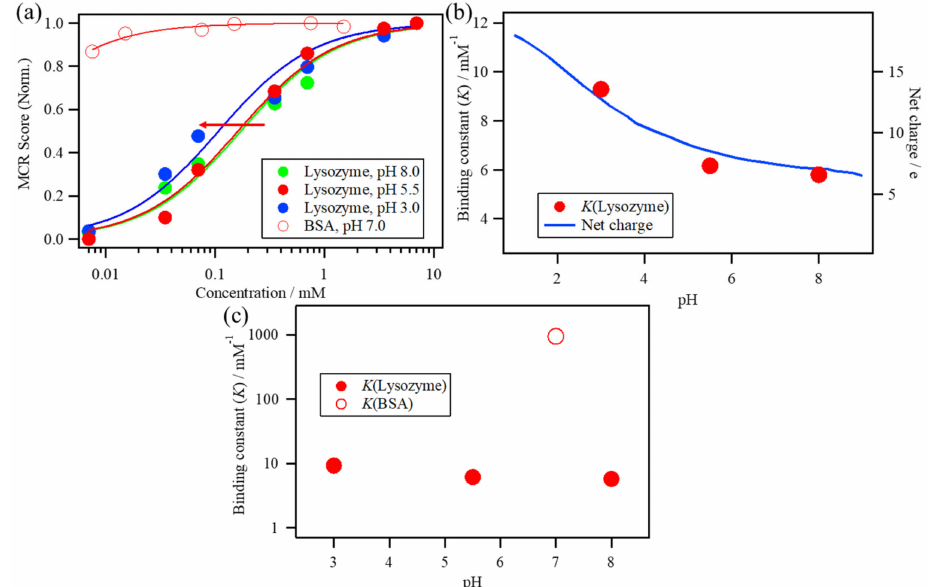
Figure 7. ( a ) The increase in MCR Score 2 of the lysozyme solutions at pH 8.0, 5.5, and 3.0 and the BSA solution plotted against the protein concentration. ( b ) The estimated K value of the lysozyme solutions at pH 8.0, 5.5, and 3.0 with the calculated net charge of lysozyme as a function of pH. ( c ) The estimated K value of the ANS–BSA binding with one of the lysozyme